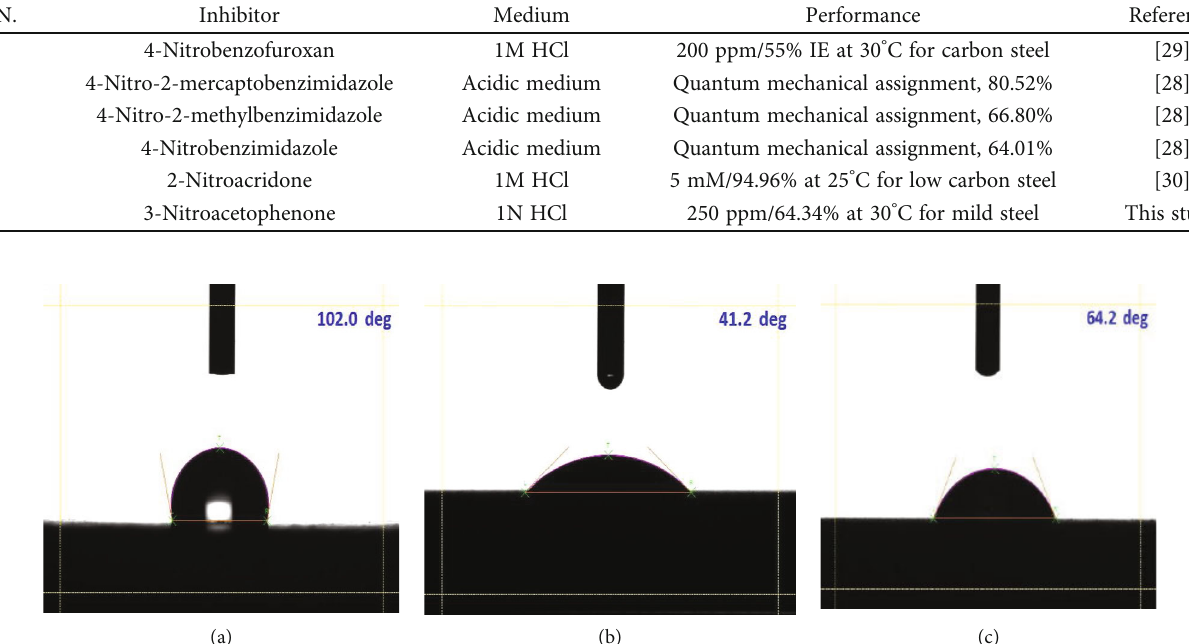
Figure 11: Sessile drop method: contact angle of (a) polished mild steel, (b) mild steel immersed in 1N HCl, and (c) mild steel immersed in 250ppm of